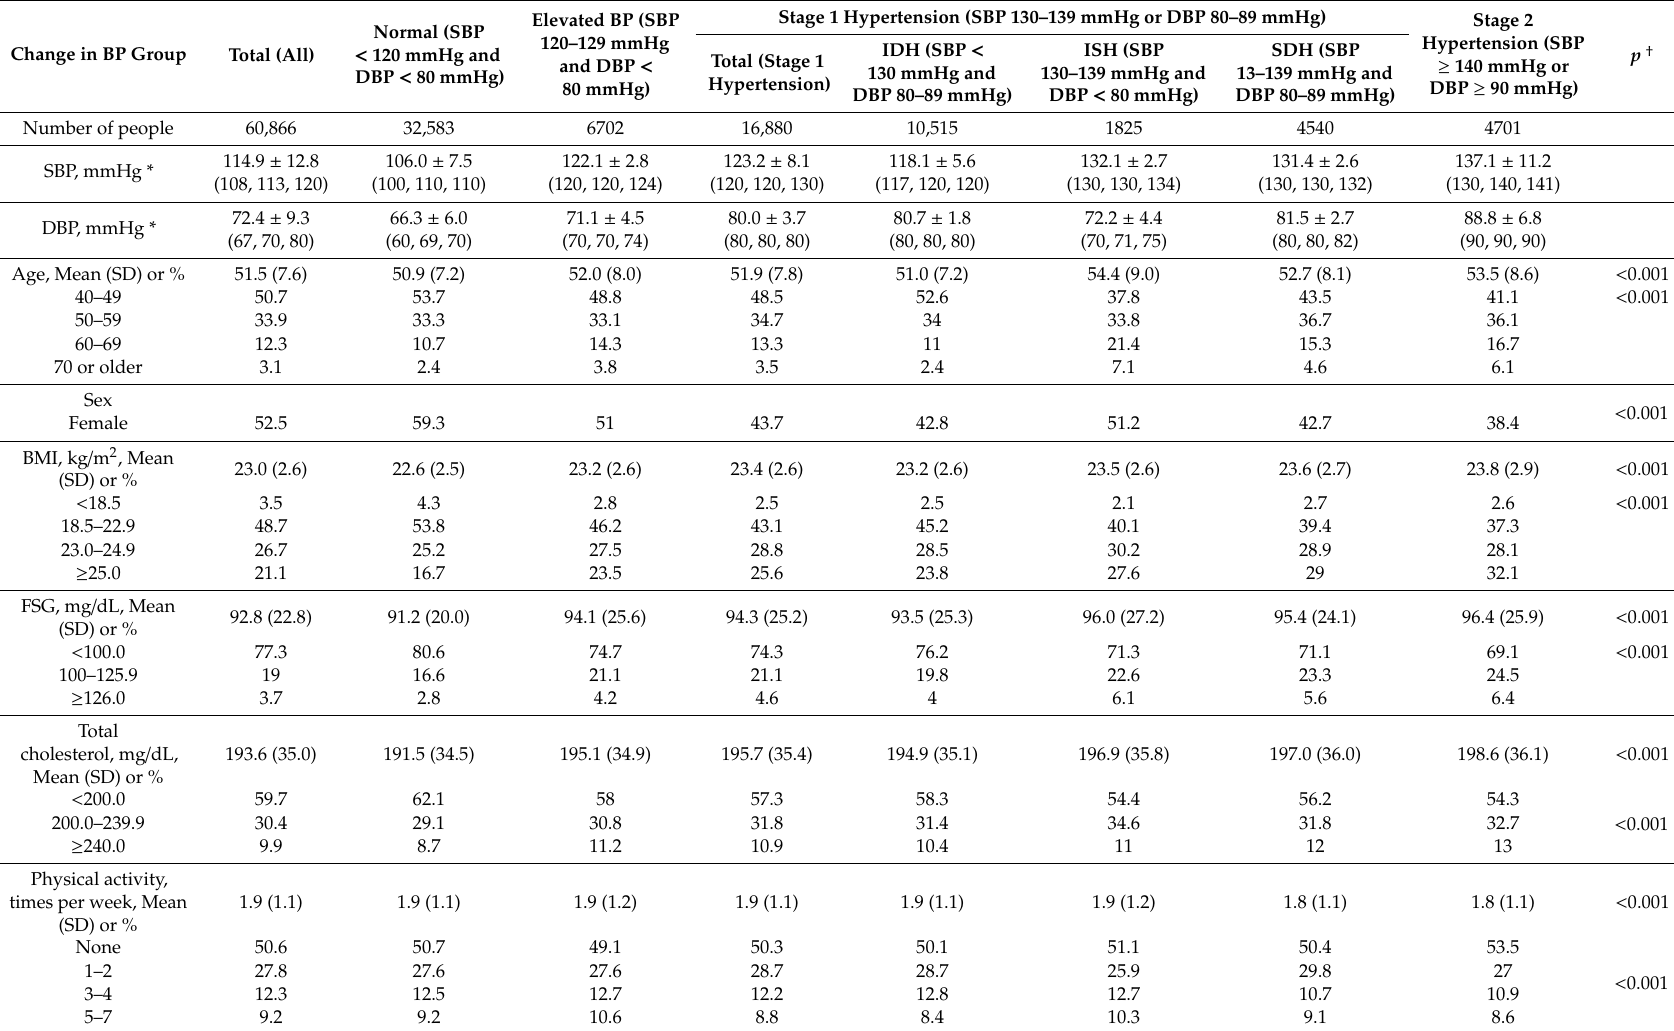
Table 1. Descriptive characteristics of study participants on their second health